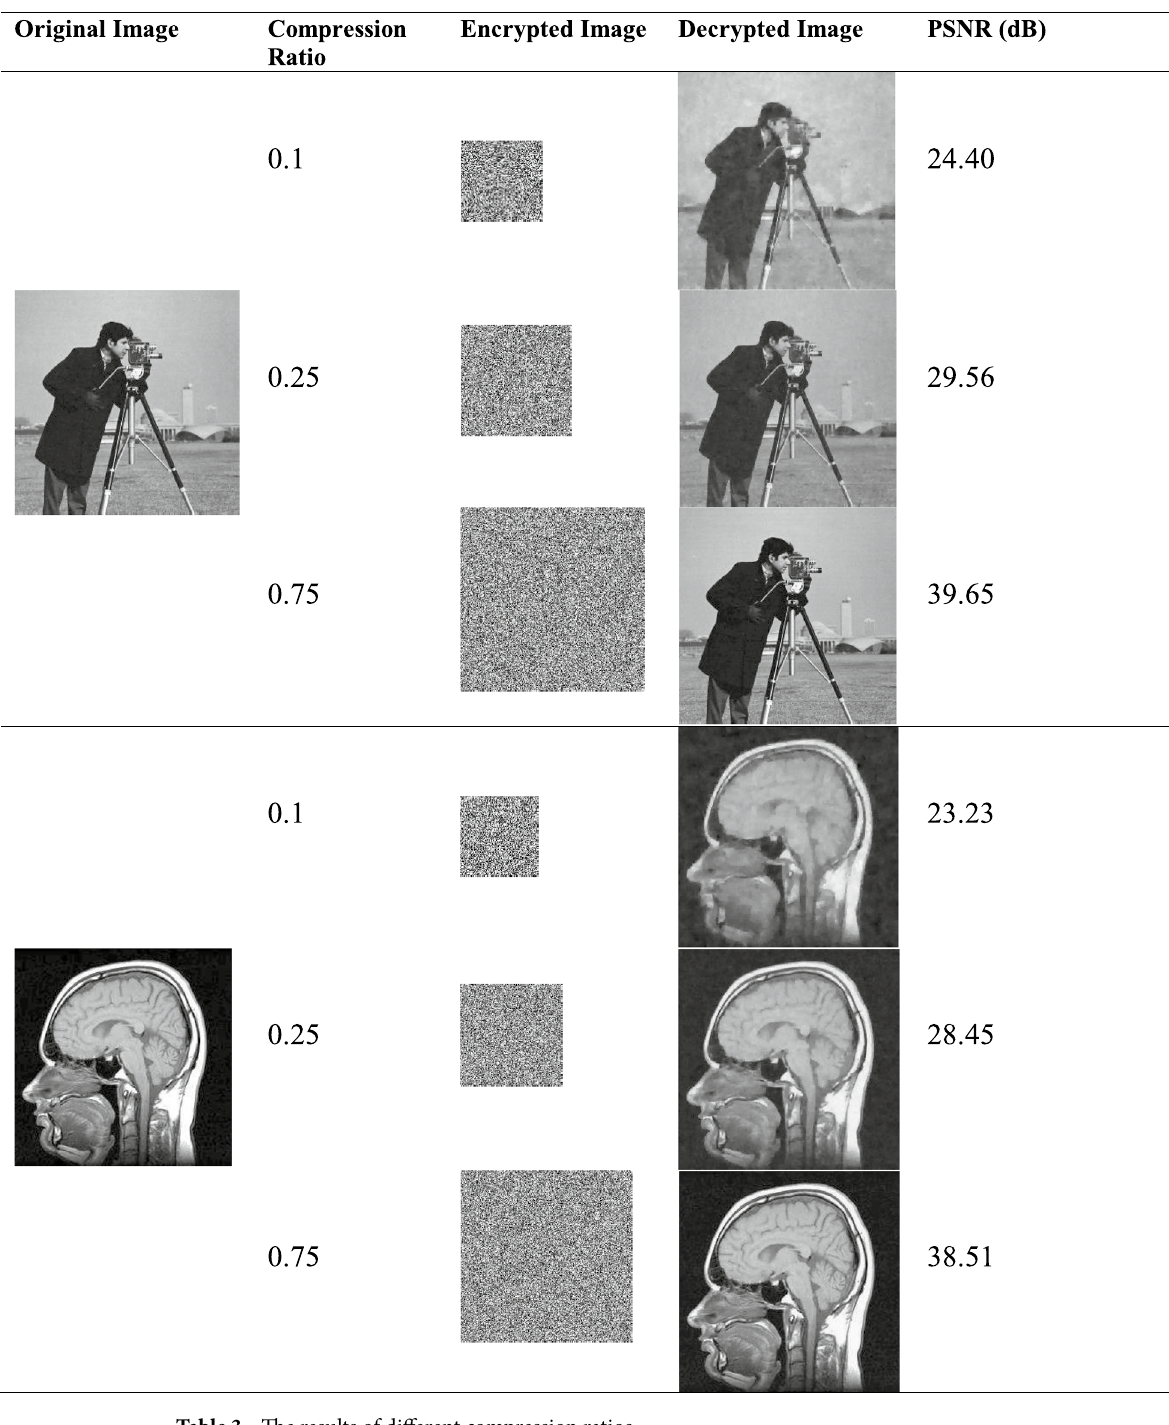
Table 3. The results of different compression